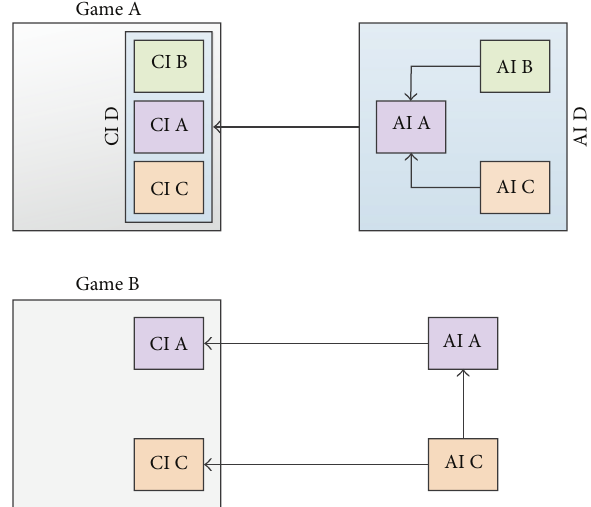
Figure 5: AI dependency in combined and individual solutions. Arrows represent requirement. A combination of AI solutions (AI D) has its own conceptual interface (CI D) which includes those of its components, making AI dependency transparent to game developers. In the case of separate AI solutions, a dependency (AI C requires AI A) translates into an additional conceptual interface (CI A) for game developers to